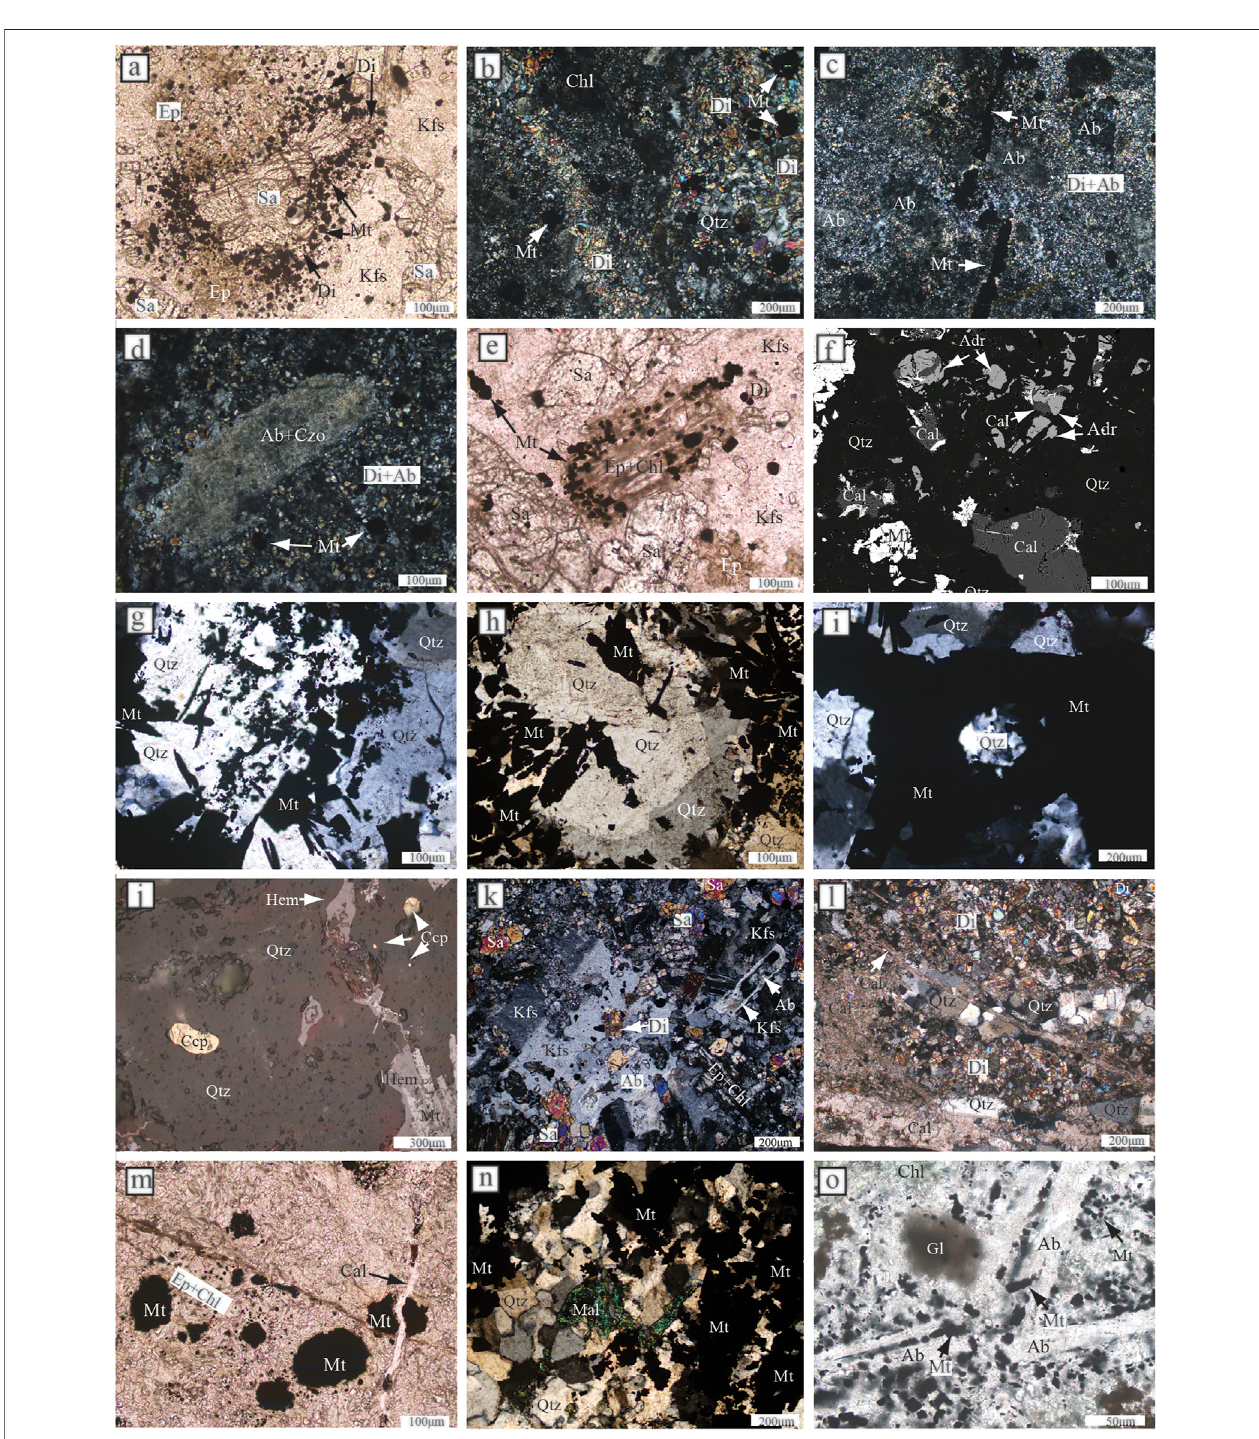
FIGURE 4 | (A) Clinopyroxene is densely disseminated or presents as veinlets near the contact zone; (B) Magnetite is sparsely disseminated; (C) Magnetite veinlets; (D) Clinopyroxene is metasomatized by epidote + chlorite + magnetite, and epidotization and chloritization in the outer contact zone are well developed; (E,I) Alterations of quartz + magnetite + K-feldspar + calcite + sericite + chlorite + prehnite + actinolite + chalcopyrite + pyrite are developed in the hydrothermal stage; (F,G) The quartz – magnetite vein with a width of about 2 – 10 cm, where magnetite accounts for as much as 40 vol% of the vein volume; (J) Chalcopyrite is disseminated andmagnetiteismetasomatizedbyhematite; (K,L) CoarseK-feldspargrain,withinclusionsofdiopsideformedintheearlystage; (M) Thecalciteveinformedinthelatest stage cuts through the early-stage magnetite; (N) Malachite in the magnetite – quartz vein; (O) Wall rock of andesite is intensely mineralized with magnetite. Plane polarized light (A,E,M, and O) , cross polarized light (B – D,G – I, K,L, and N) , re fl ected light (J) , and the BSE image (F) . Ab — albite; Adr — andradite; Cal — calcite; Ccp — chalcopyrite; Chl — chlorite; Czo — clinozoisite; Di — diopside; Ep — epidote; Gl — glass; Hem — hematite; Mal — malachite; Mt — magnetite; Kfs — K-feldspar; Qtz — quartz; Sa — salite; Ser — sericite (modi fi ed after Wang and Zhu, 2010).